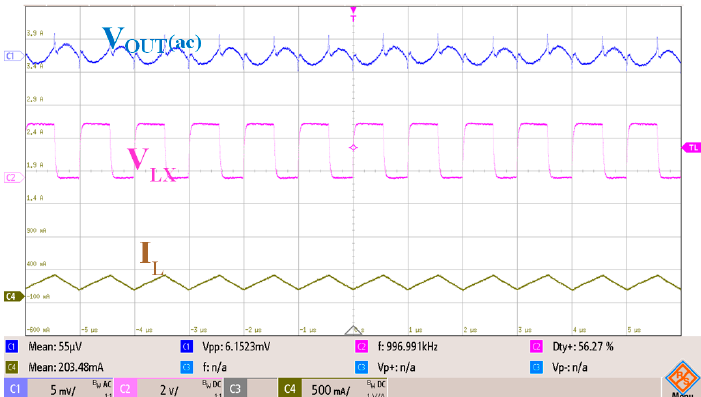
Figure 12. Measured light load output ripple of the proposed DC-DC buck converter ( V OUT = 1.8 V; I LOAD = 200 mA) .